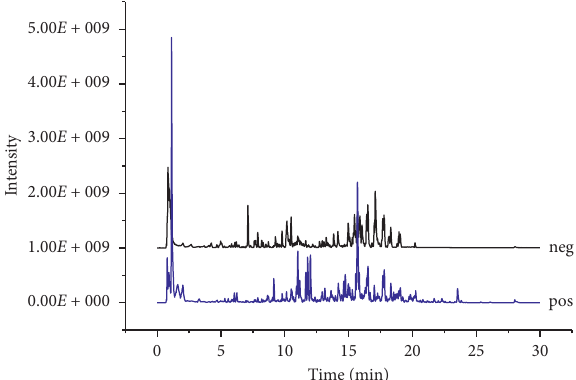
Figure 1: Total ion chromatogram of H. erinaceus in the positive ion mode (pos) and negative ion mode